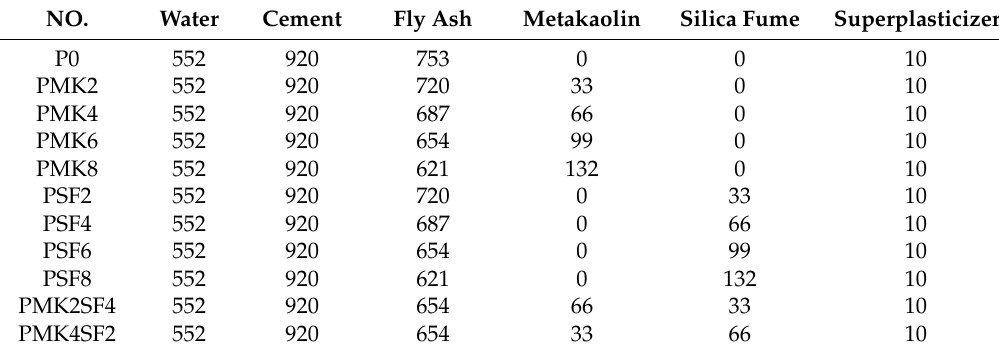
Table 2. Mix design of paste (kg/m 3 Table 2 . Mix design of paste (kg/m 3 ).